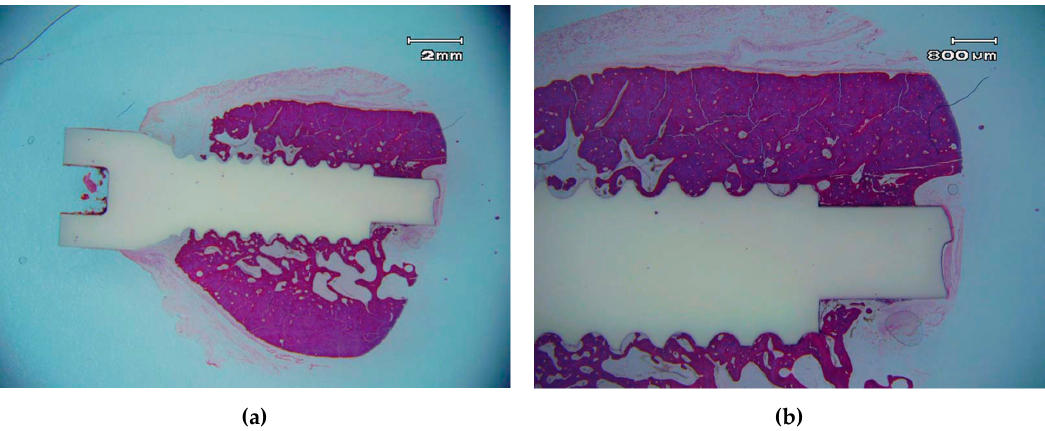
Figure 8. Osseo-integrated ZCe-A nanocomposite implant after eight weeks of implantation in the posterior maxilla of a Beagle dog at different magnifications. ( a ) scale bar 2 mm and ( b ) scale bar 800 µm